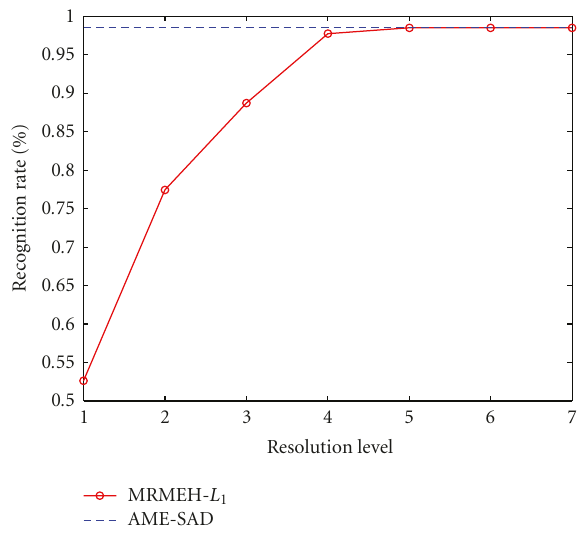
Figure 10: Comparison between MRMEH- L 1 and AMD-SAD in terms of recognition